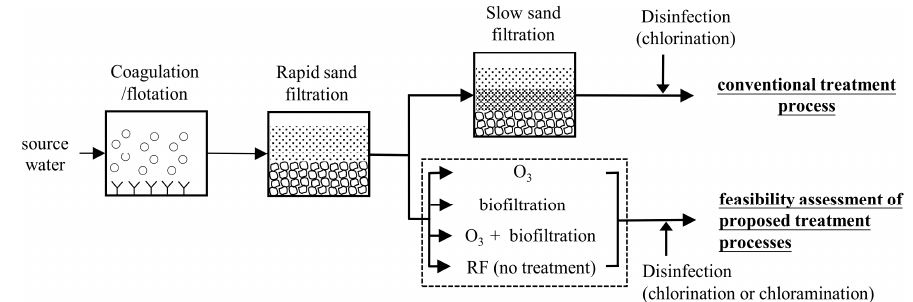
Figure 1. The conventional processes implemented by a water treatment plant on Kinmen Island and the proposed alternative treatments (dashed-line box) of this study. RF—rapid sand effluent.